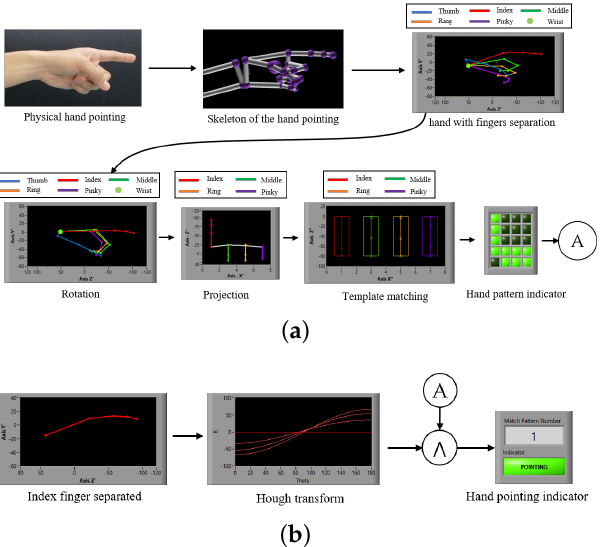
Figure 26. Example of process of hand pointing determination: ( a ) Hand pointing determination and